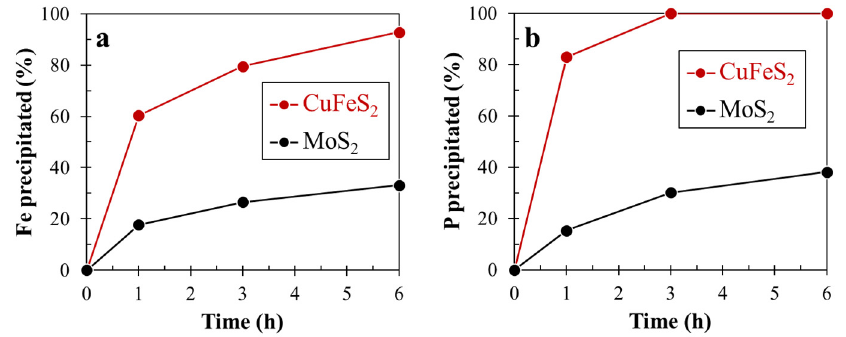
Figure 4. Precipitation rates of dissolved Fe ( a ) and P ( b ).